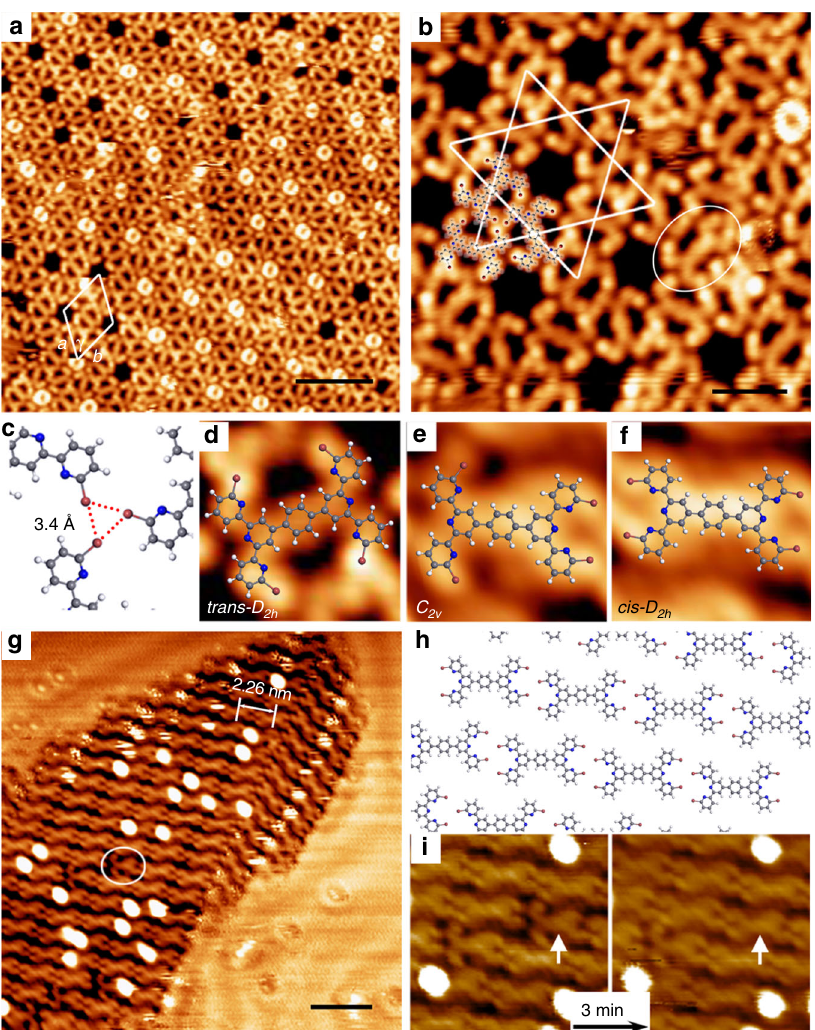
Fig. 2 Molecular conformers and assembled structures of intact p - DBTB . a STM overview of the Kagome networks monitored at T = 113 K. A unit cell is highlighted by the rhombus ( a = b = 3.35 nm, γ = 60°). b Most of the molecules appear in the trans-D 2h shape. A “ defect ” , C 2v -conformer, is indicated by an ellipse. Tentative structural model of a trimeric cluster is overlaid. Carbon, gray; nitrogen, blue; bromine, red; hydrogen, white. c Br···Br halogen bonds of a trimeric cluster. d – f Magni fi ed topographs of the trans-D 2h , C 2v and cis-D 2h conformers, overlaid by the corresponding molecular models. g A close-packed island composed of cis-D 2h conformers observed at 293 K. A “ defect ” , C 2v conformer, is marked by an ellipse. h Tentative structural model of the close- packed structure. i Spontaneous conformational transition of the molecules monitored at 293 K. One C 2v conformers (marked by an arrow) was transformed into a cis-D 2h conformer during a continuous scanning in 3 min. Scale bars: ( a ) 5 nm; ( b ) 2 nm; ( g ) 3 nm. Data acquisition conditions ( U, I, T ): ( a , b , d and e ) − 1.5 V, 0.2 nA, 113 K; ( f ) − 1.2 V, 0.1 nA, 293 K; ( g , i ) − 1.2 V, 0.1 nA, 293